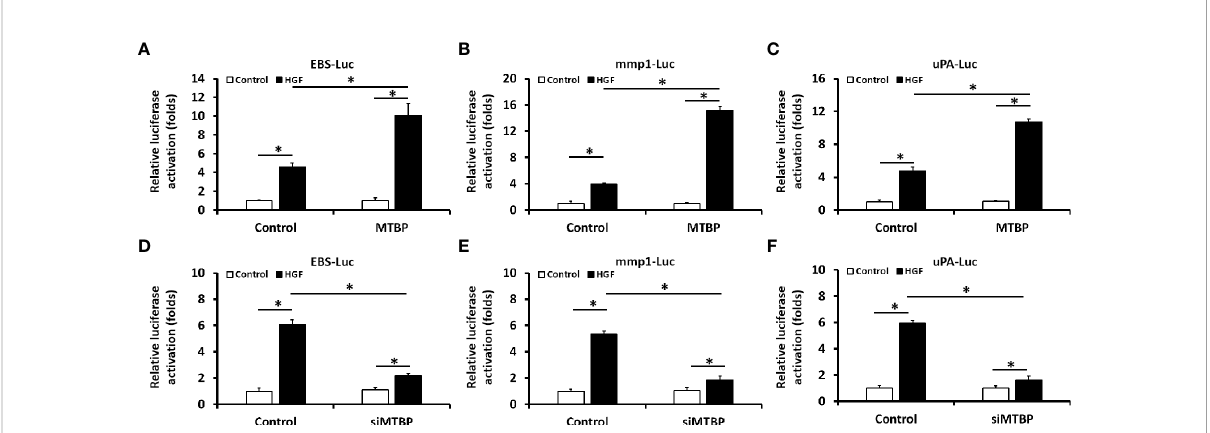
FIGURE 1 Oncoprotein murine double minute (MDM2) binding protein (MTBP) causes enhancement of the transcription factor activation of transcription factor E26 transformation speci fi c sequence (ETS-1) in hepatocellular carcinoma (HCC) cells. (A – C) The effect of MTBP overexpression in MHCC97-L cells on the activation of luciferase reporters (A [ETS-Luc]; B [mmp1-Luc]; C [uPA]) induced by hepatocyte growth factor (HGF). (D – F) The effect of MTBP knockdown (MTBP siRNA) in MHCC97-H cells on the activation of luciferase reporters (A [EBS-Luc]; B [mmp1-Luc]; C [uPA]) induced by HGF. *P < 0.05.